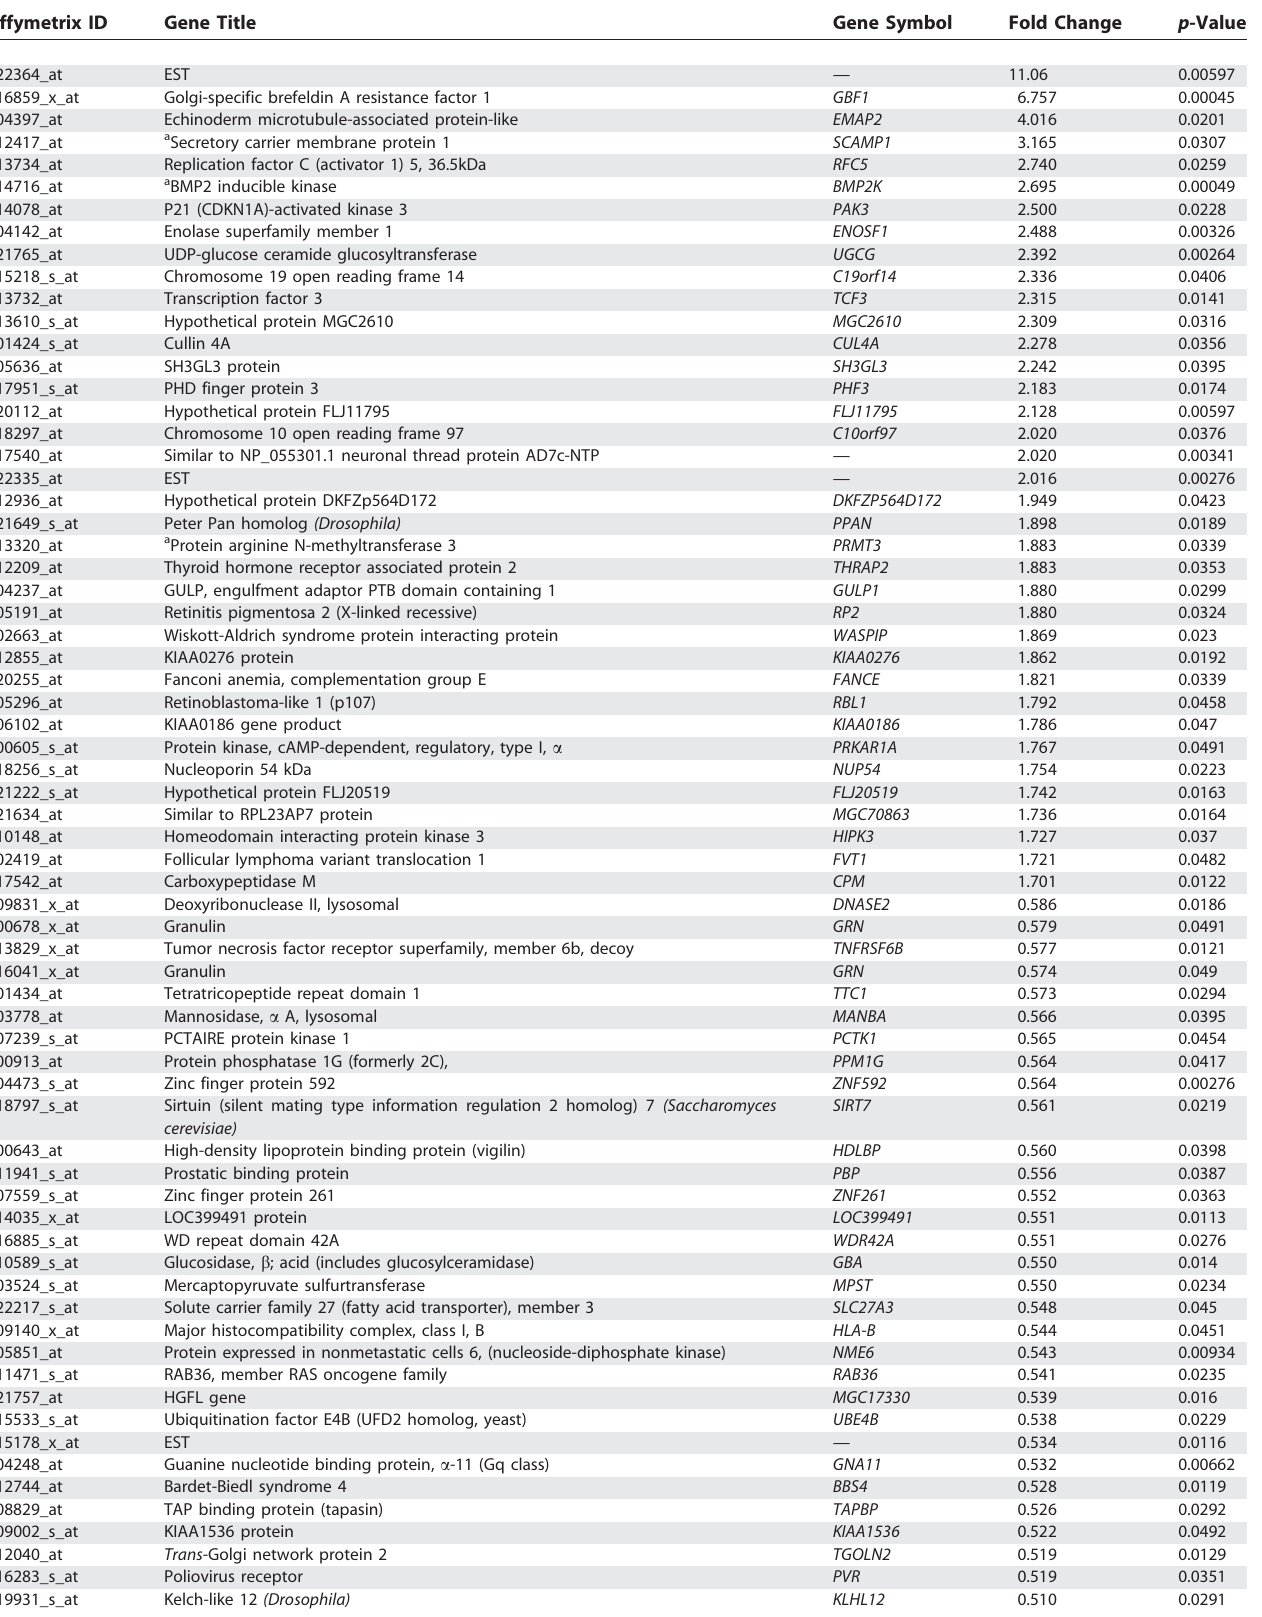
Table 4. Genes that Changed by More than 1.7-Fold in 100 l M ADMA-Treated HCAEC Compared to